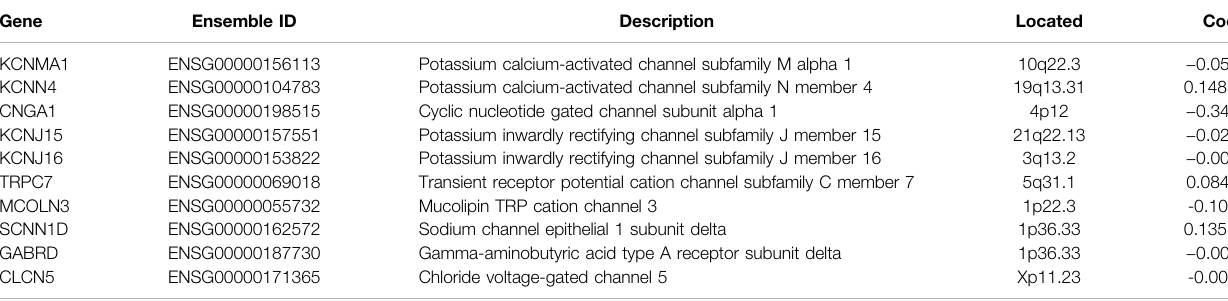
TABLE 2 | Detailed information of the ICRGs in the prognostic signature.